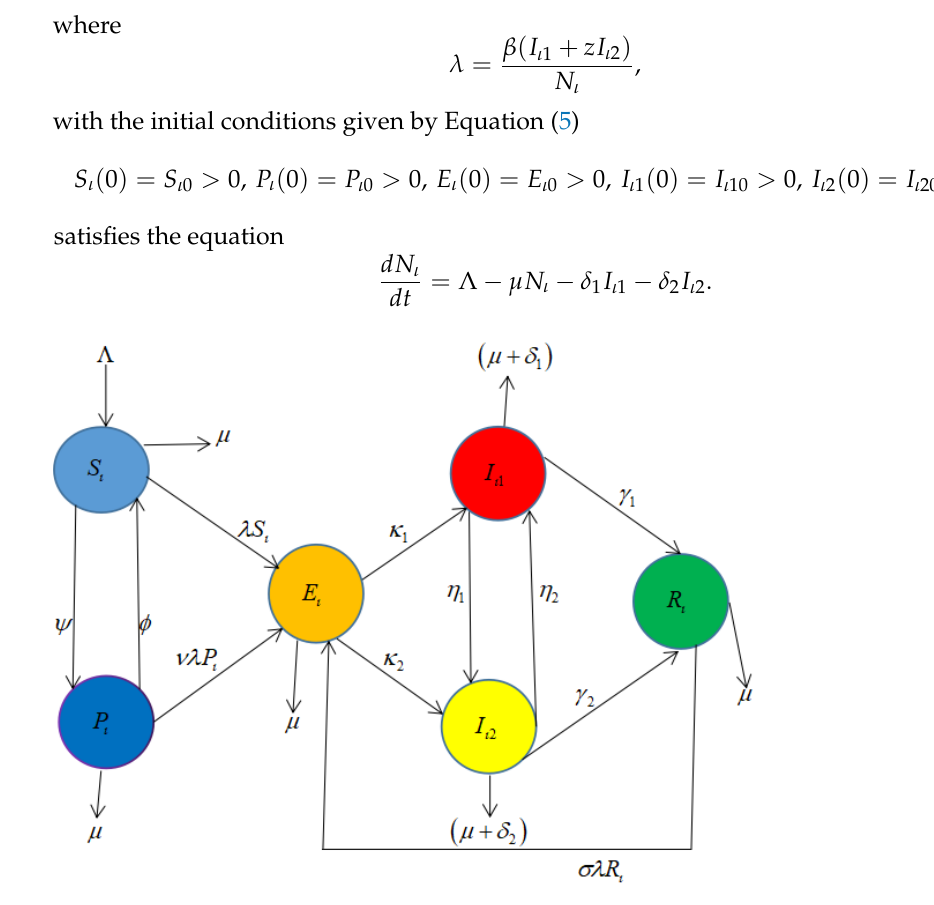
Figure 1. The flow diagram of TB model with public health education and hospital treatment. Table 1. Interpretation of the Variables and Parameters of the TB Model with Public Education and hospital Treatment